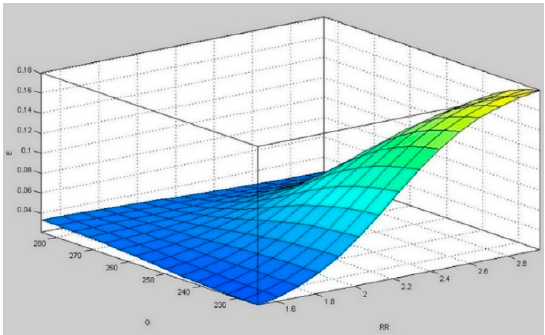
Figure 7. Energy (E) in relation to change of gape (G) and the reduction ratio (RR).